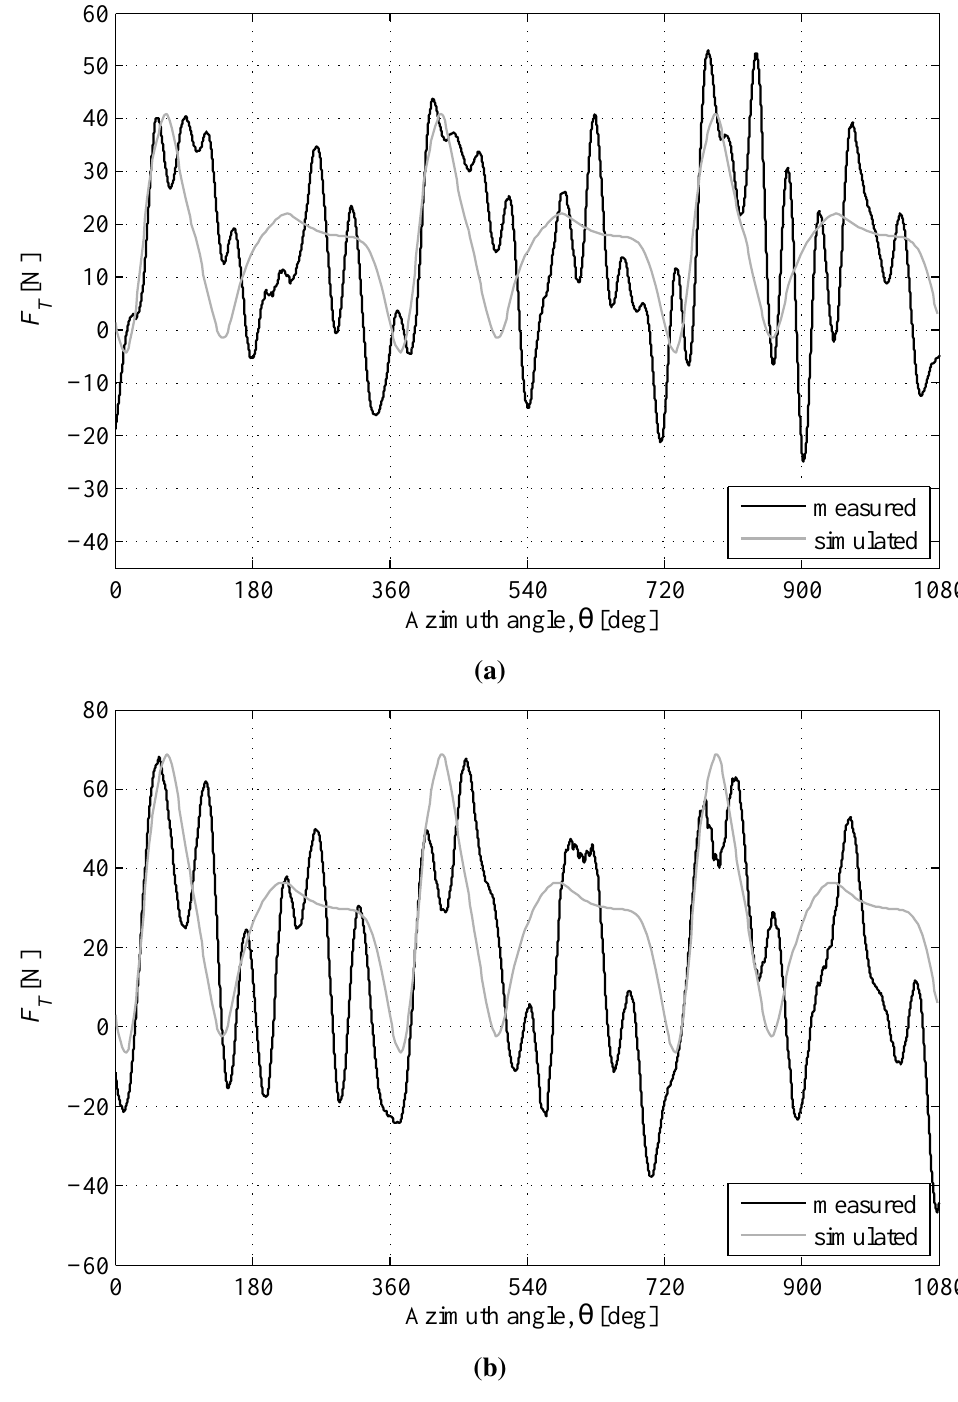
Figure 11. Comparison of measurements and simulations of F speeds. ( a ) Tangential force response at λ = 3 . 59 and (cid:104) Ω ρ = 1 . 275 kg / m 3 ; ( b ) Tangential force response at λ = 3 . 58 and (cid:104) Ω Air density ρ = 1 . 236 kg / m 3